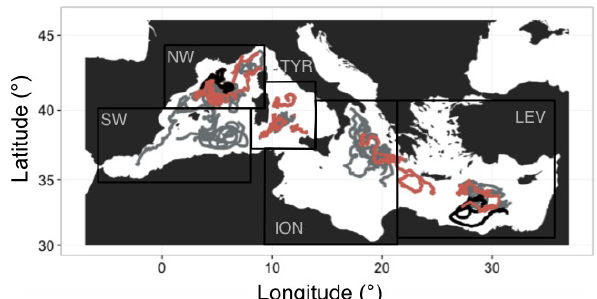
Figure 1. Geographic location of the multivariable vertical profiles collected by the BGC-Argo profiling floats in the Mediterranean Sea. The boundaries of the regions considered in this study are indi- cated by the black rectangles. NW, SW and TYR correspond to the western basin regions, whereas ION and LEV represent the eastern basin regions. Red indicates BGC-Argo floats equipped with nitrate sensors. Black indicates the specific BGC-Argo floats equipped with nitrate sensors that are used in Figs. 10 and